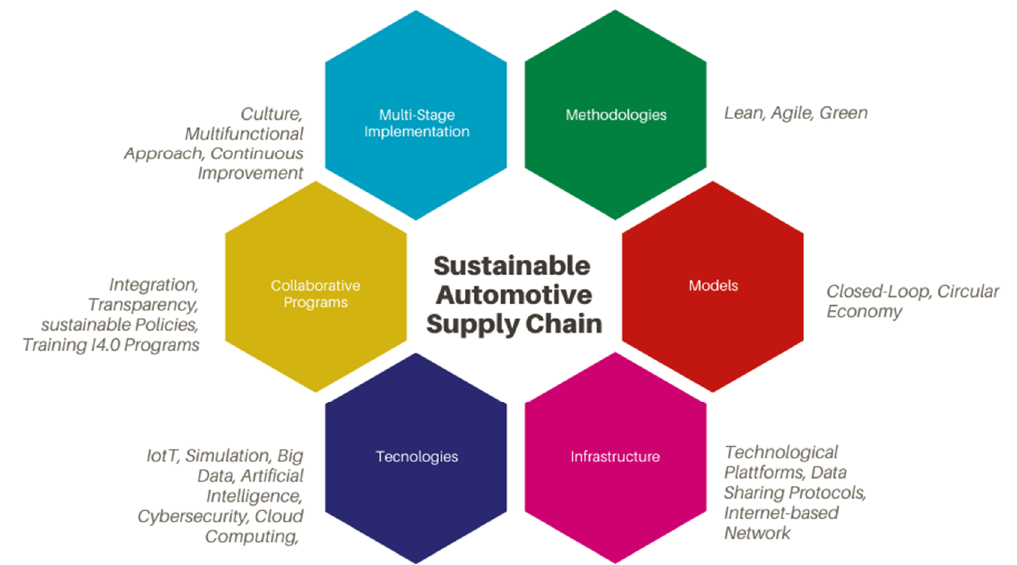
Figure 4. Sustainable Supply Chain